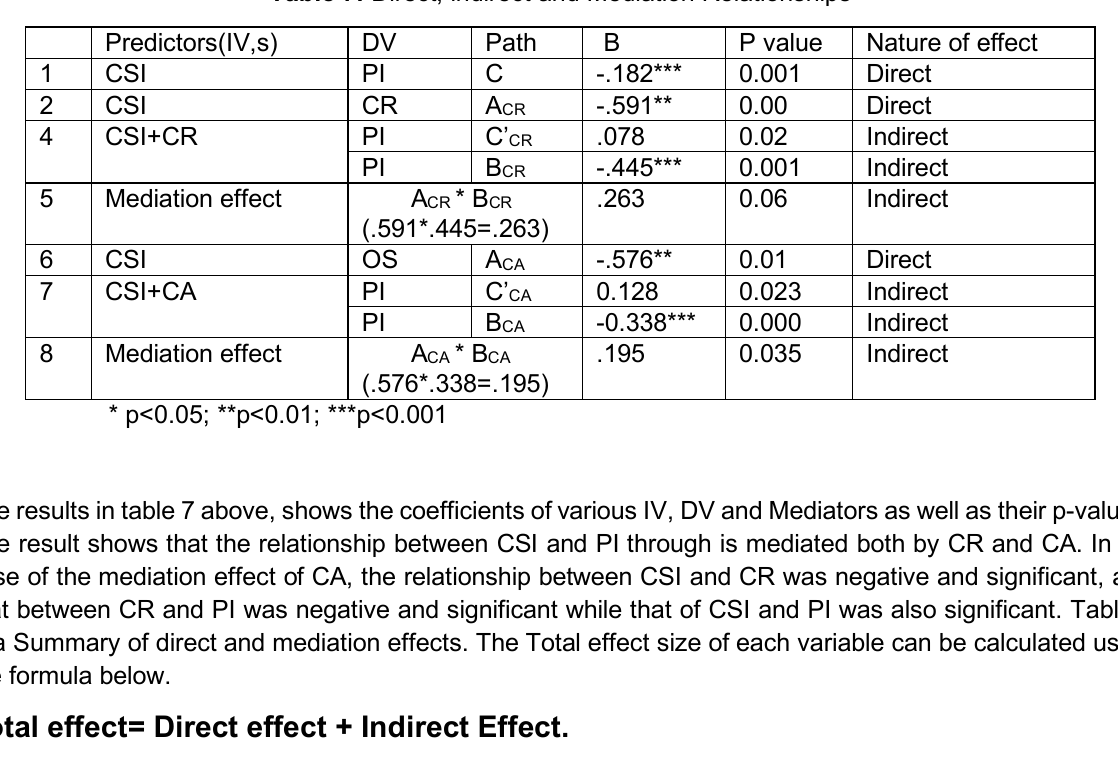
Table 7: Direct, indirect and Mediation